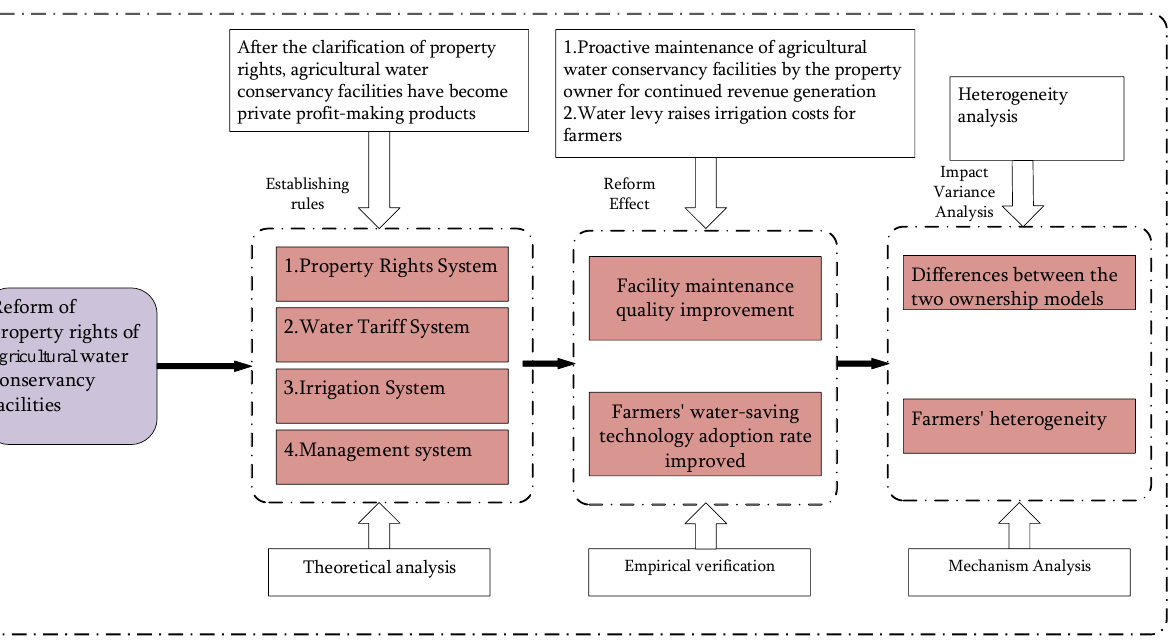
Figure 3. Theoretical analysis framework.